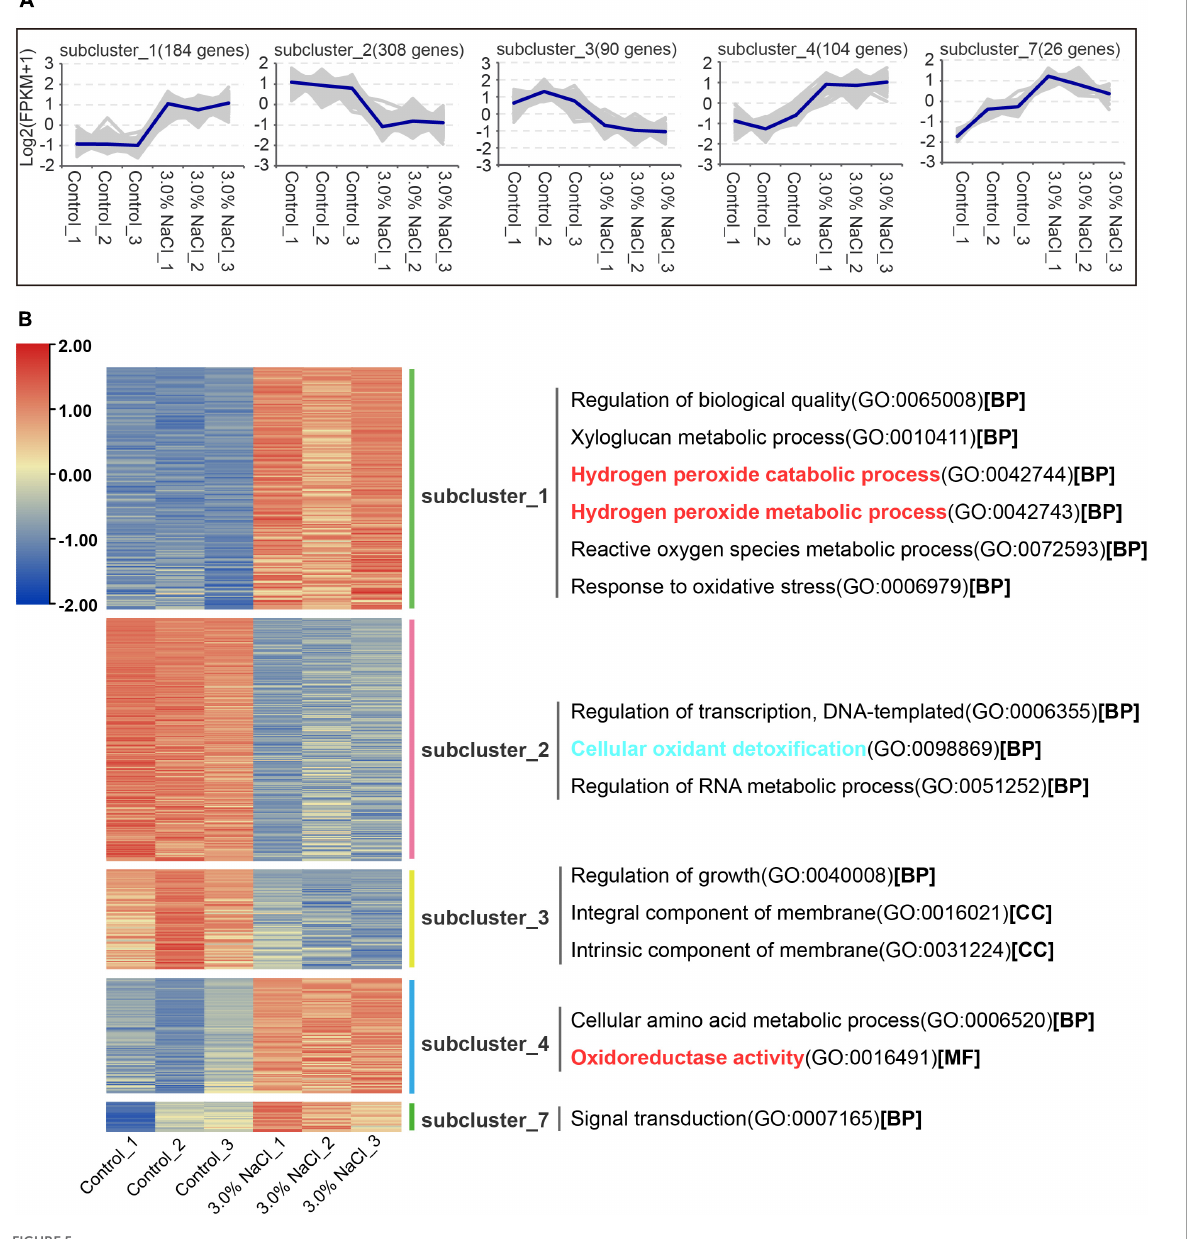
The control and 3.0% NaCl unigenes were compared using GO enrichment analysis. The genes (859) in the control vs. the 3.0% NaCl were significantly upregulated and were enriched in several processes related to microtubules, such